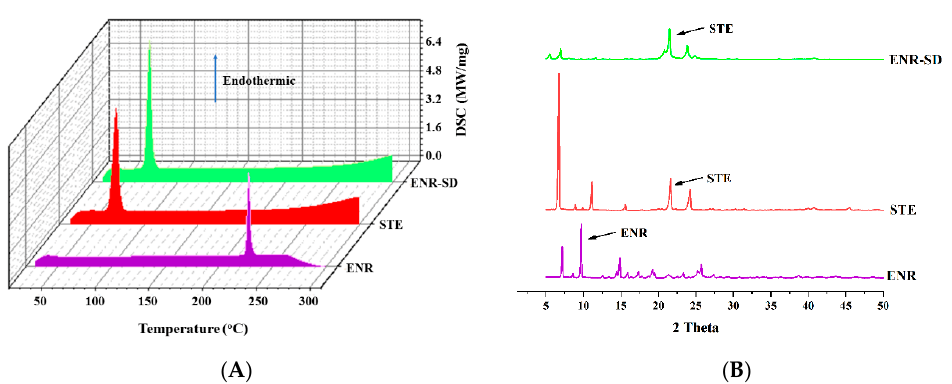
Figure 5. The DSC ( A ) and the XRD ( B ) analysis of ENR-SD. The ENR presented as an amorphous form in the ENR-SD. Note: ENR, enrofloxacin; STE, stearic acid; STA, starch.